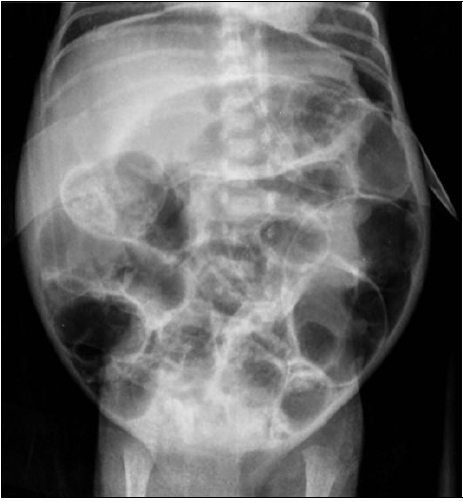
Figure 1: Abdominal x-ray showing pneumoperitoneum. Figure 2: Intraoperative picture showing 0.5 cm perforation at the first segment of anterior wall of duodenum (Yellow arrow). Blue arrow showing fibrin adhered to the inferior side of the